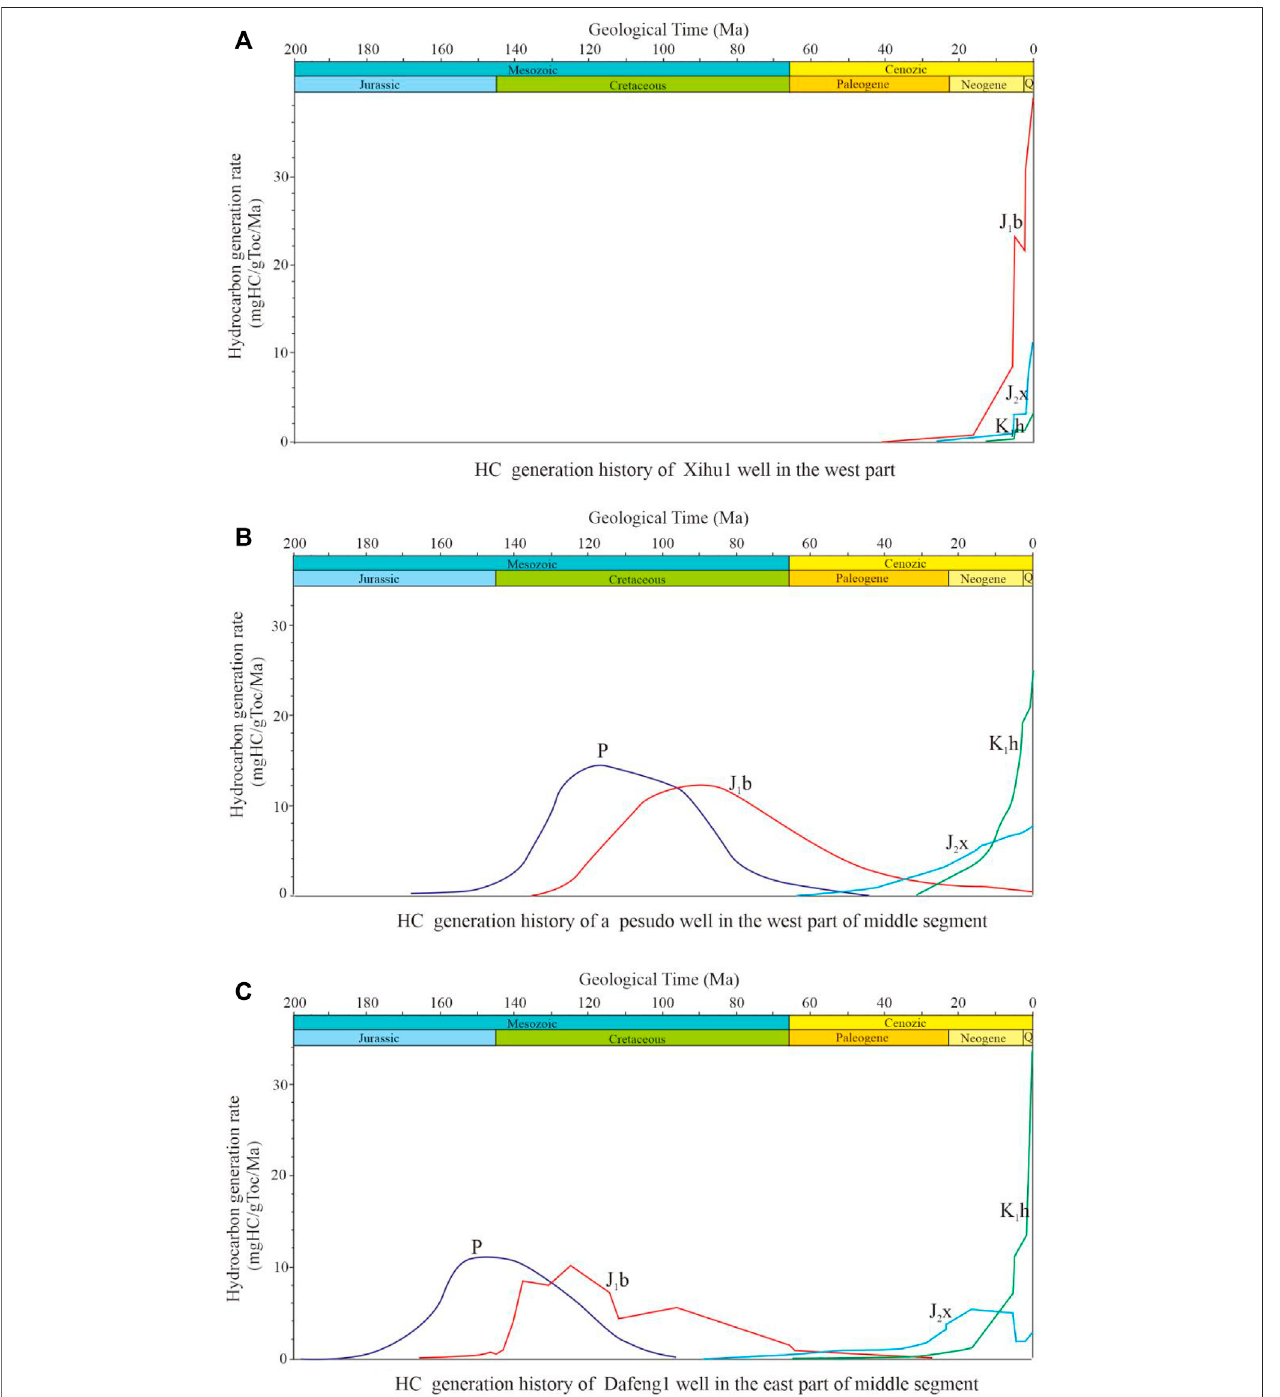
FIGURE10| HydrocarbongenerationhistoryofrepresentativewellsindifferentregionsintheSouthernJunggarbasin. (A) HCgenerationhistoryofXihu1wellinthe west segmentofsouth JunggarBasin. (B) HC generationhistory ofapseudo well inthe west part ofofmiddle segment. (C) HC generationhistory ofDafeng1well inthe east part of middle